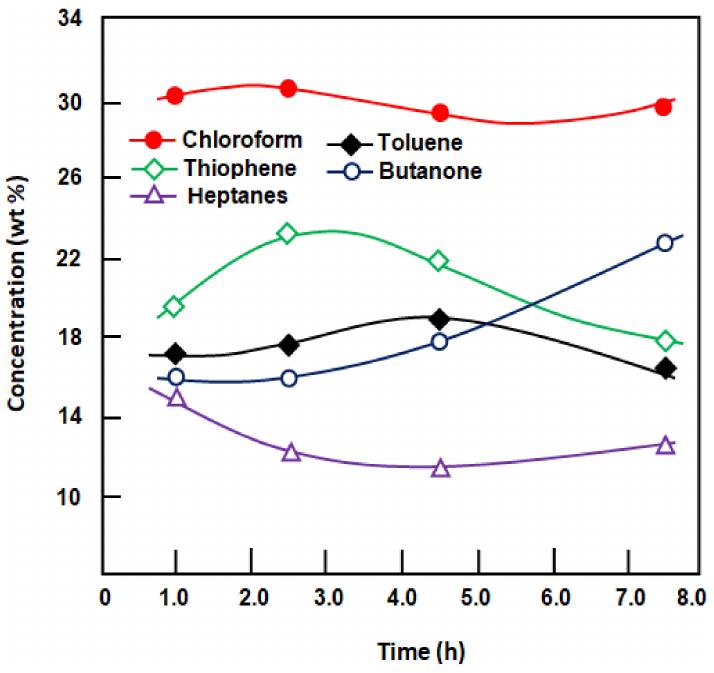
Figure 14. Variation of the concentration of various organic components in the permeate as a function of time obtained during separation by pervaporation (dynamic